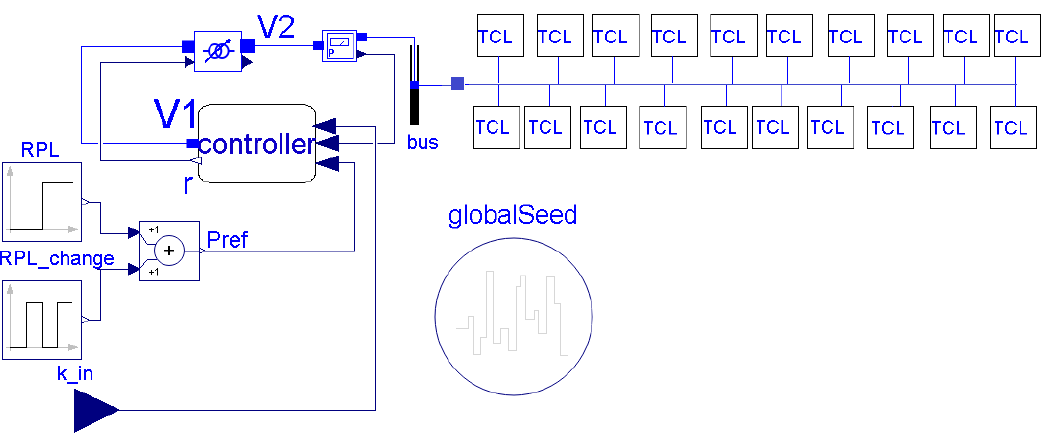
Figure 3. Diagram of a simulated power system (20